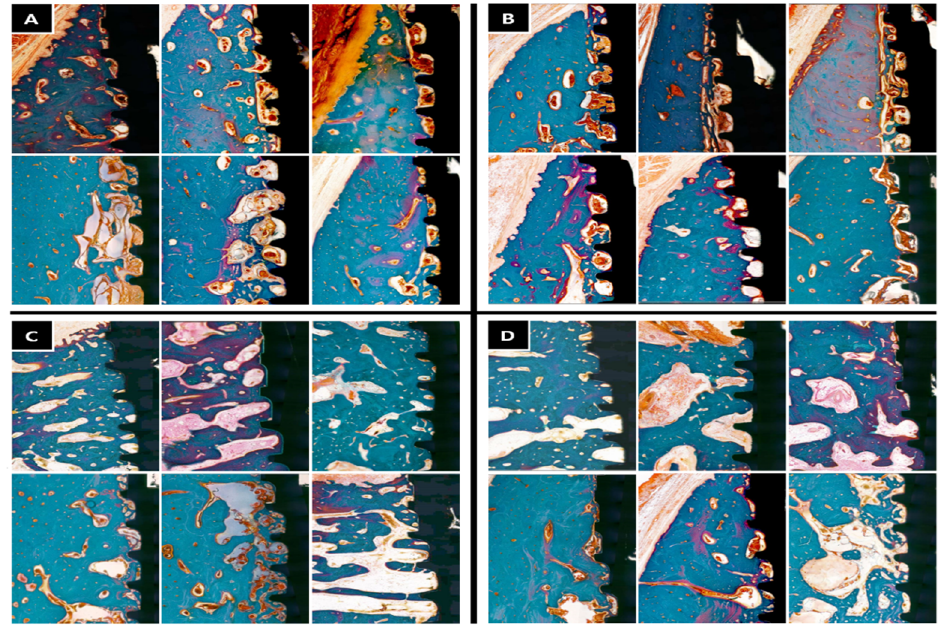
Figure 3. View of specimens: (A) ultraviolet irradiation group at 4 weeks, (B) non-irradiated group at 4 weeks, (C) ultraviolet irradiation group at 12 weeks, and (D) non-irradiated group at 12 weeks. None of the implants showed a significant difference in BIC measurement between the two groups at 4 and 12 weeks ( p > 0.05). The mean BIC values were 44.6 ± 10.8% at 4 weeks and 72.7 ± 6.0% at 12 weeks in the UV-irradiated group. The mean BIC values were 39.6 ± 13.2% at 4 weeks and